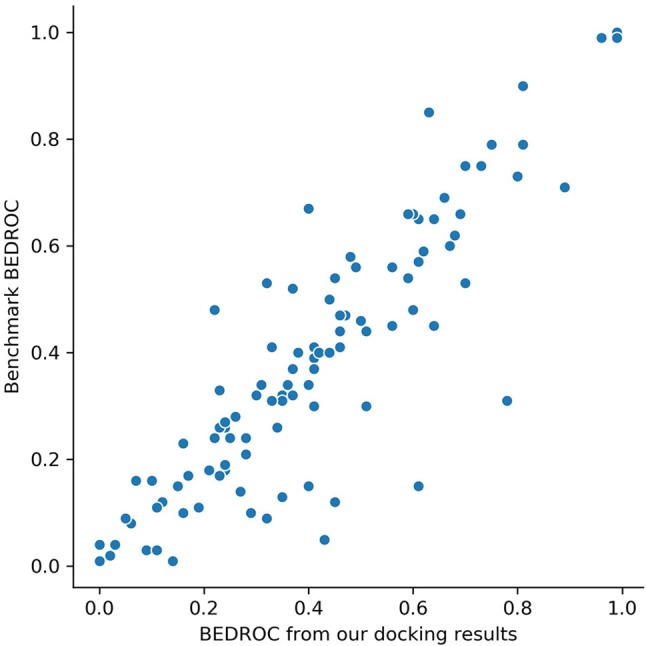
BEDROC scores (α=80.5) on 102 targets of our screening results versus the results from benchmark (Chaput et al., 2016). Each dot represents a target.